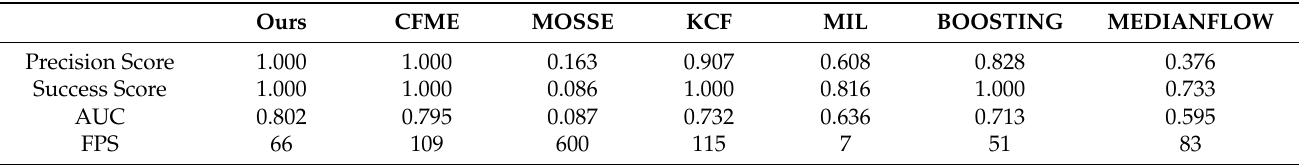
Table 4. Results of video2.